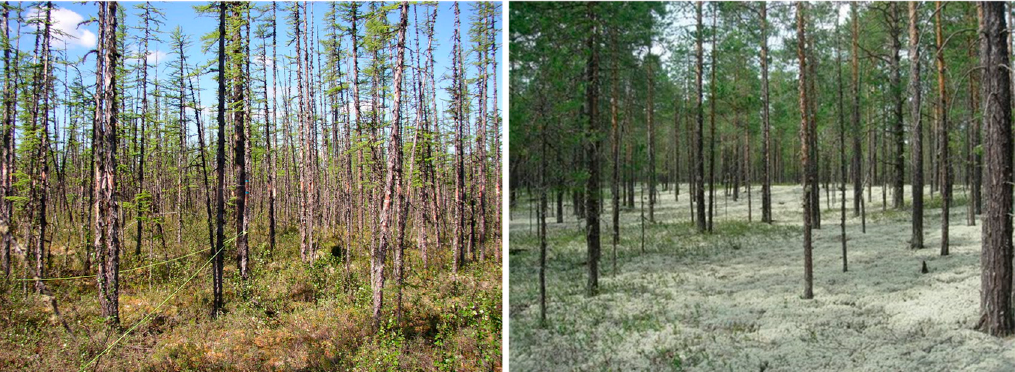
Figure 2. Study sites: the Larix gmelinii with Pleurozium schreberi and Aulacomnium turgidum and dwarf-shrubs forest floor ( left ) and the Pinus sylvestris with Cladonia , Cladina , and Cetraria forest floor ( right ).